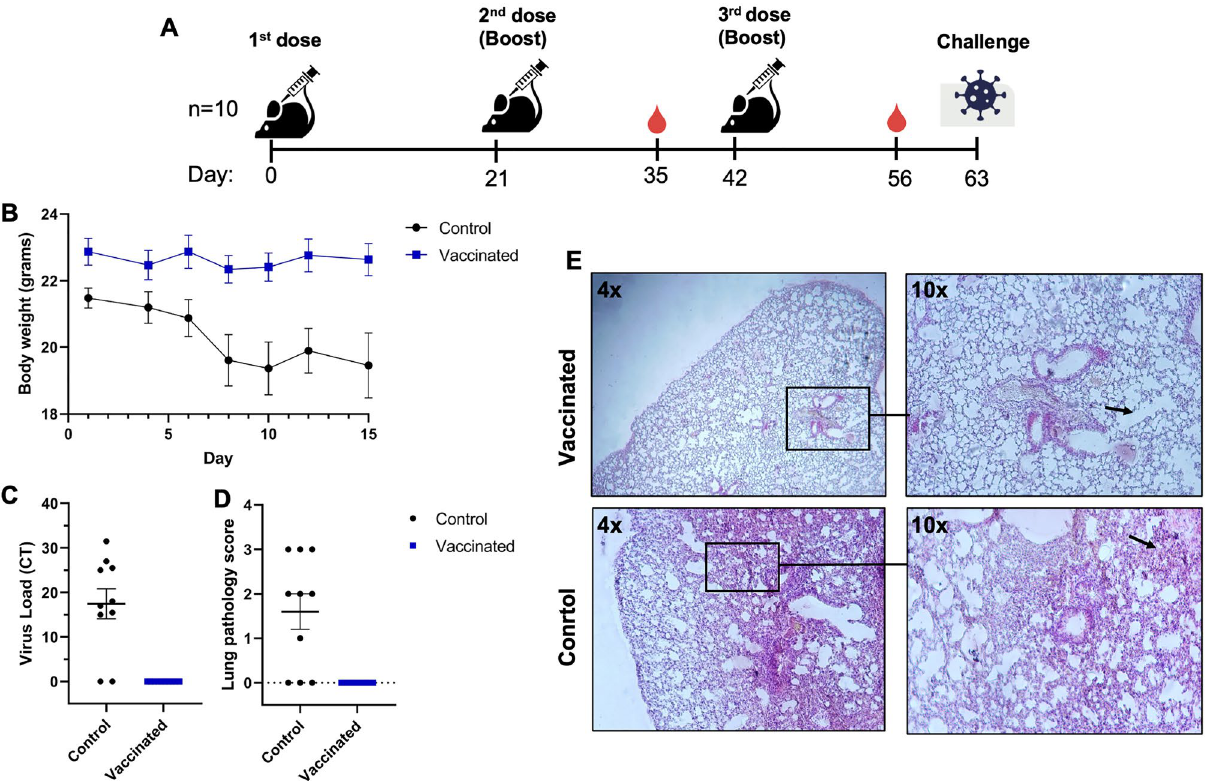
Figure 6. Immunoprotective activity in SARS-CoV-2-infected K18-hACE2 transgenic mice. ( A ) Study design for the animal immunizations and challenge. ( B ) Average animal weights post challenge. ( C ) CT (cycle threshold) values from qRT-PCRs against the nucleocapsid as indication of the infectious virus loads in lung homogenates by Real-Time PCR against the nucleocapsid as CT (cycle threshold) values. ( D ) Pathological inflammation scores of mice lungs. The lung inflammation was scored from 0 to 3 (0: no inflammation, 1: low, 2: medium, 3: high). ( E ) Representative images of hematoxylin–eosin stained lung tissues obtained from vaccinated (first row), and control (second row) groups with a magnification of 4 × (left) and 10 ×